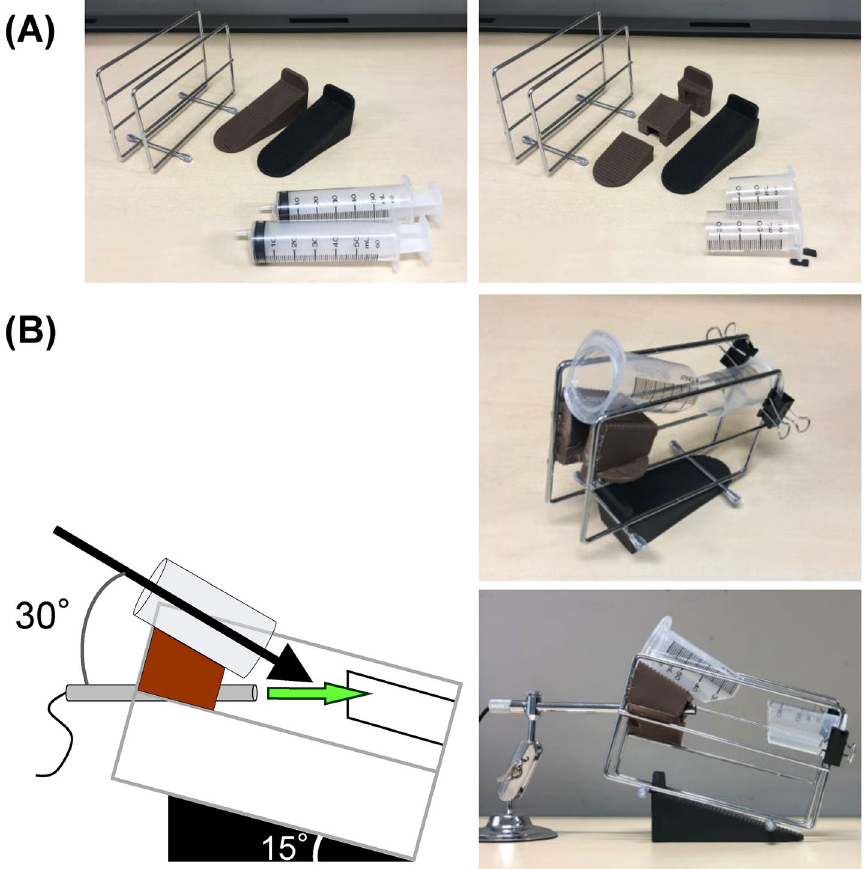
Figure 2. Materials of basic framework used for the training kit. ( A ) Materials for the basic framework. Left panel, before cutting; right panel, after cutting. ( B ) After assembly. Note that the initial concept was achieved.